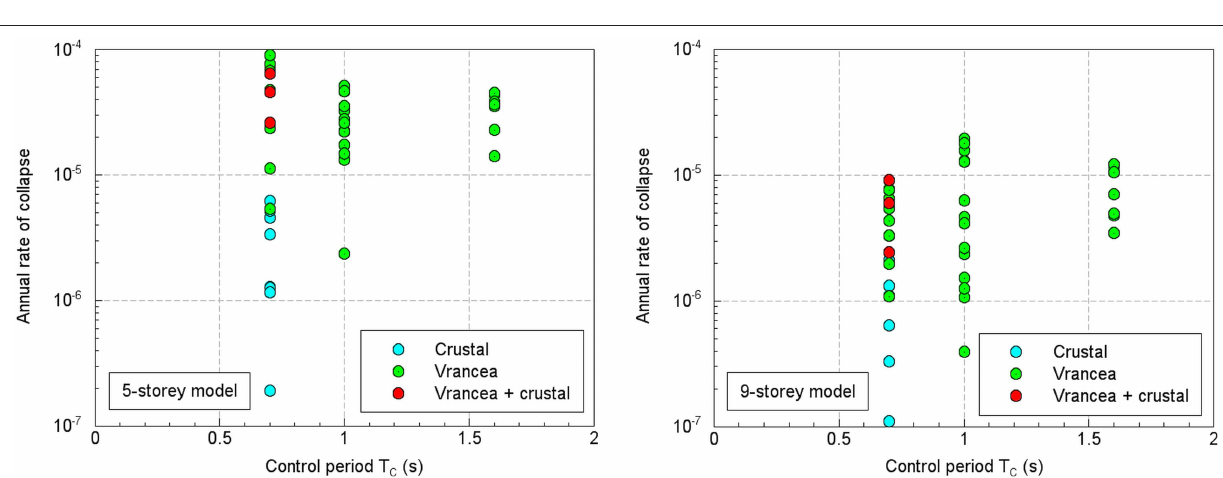
acceleration [as also observed for Italy by Iervolino et